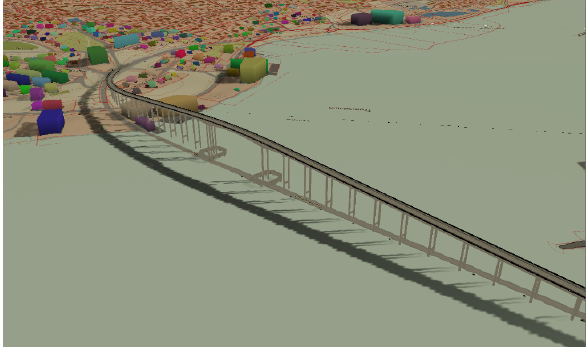
Figure 10: Shadow casting in Norut Geo Viz. The model of the bridge is made by Bent Ebeltoft, and is available from the Trimble 3D warehouse. The box buildings are generated based on polygons extracted from the Norwegian Mapping Authority raster map